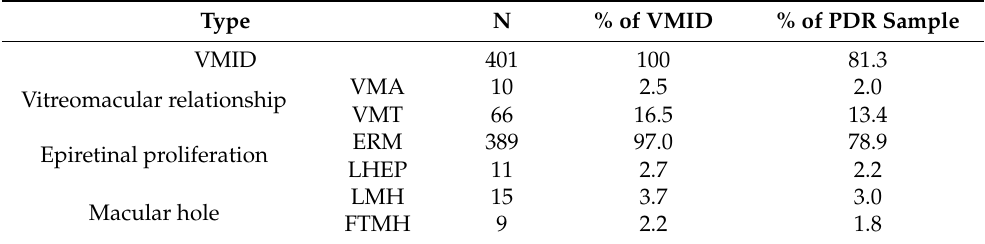
Table 1. Prevalence of vitreomacular interface disorders in proliferative diabetic